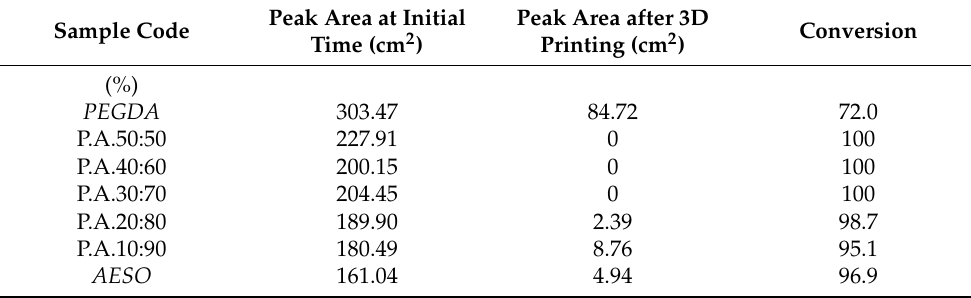
Table 2. Double-bond conversion at 810 cm − 1 for PEGDA , AESO , and their